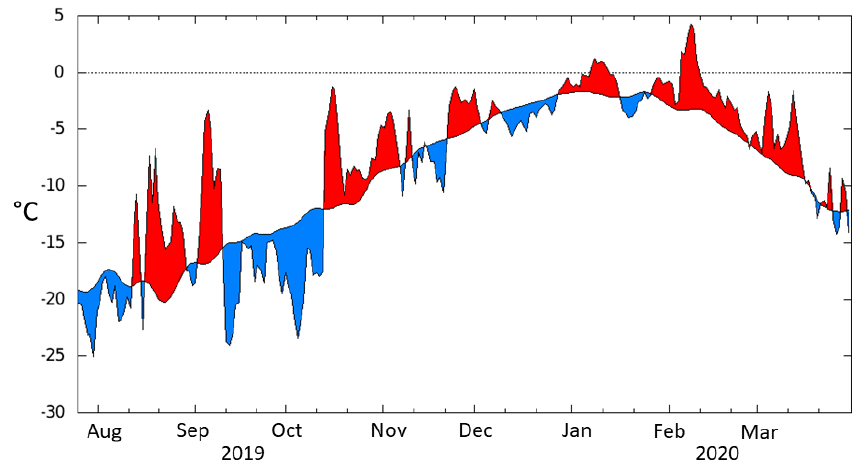
Figure 5. Mean daily and 1979–2019 mean ERA5 2m air temperatures averaged over the area − 65 to − 70 ◦ N, 60 to 65 ◦ W. Positive (negative) anomalies are shaded red (blue).